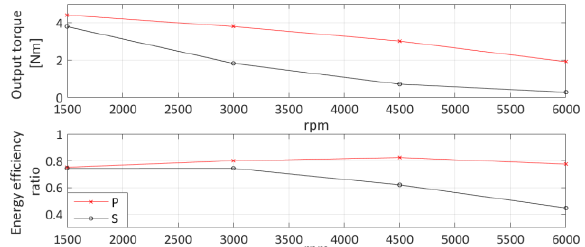
Fig. 5. Output torque vs. phase supply ranges at different rotational speeds in the parallel configuration (P).